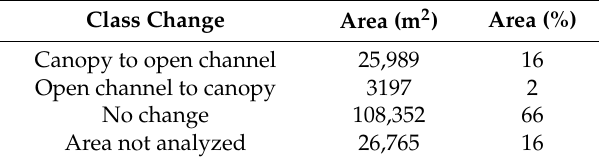
Table 2. A summary of the percent area that shifted cover classes from August 2015 to August